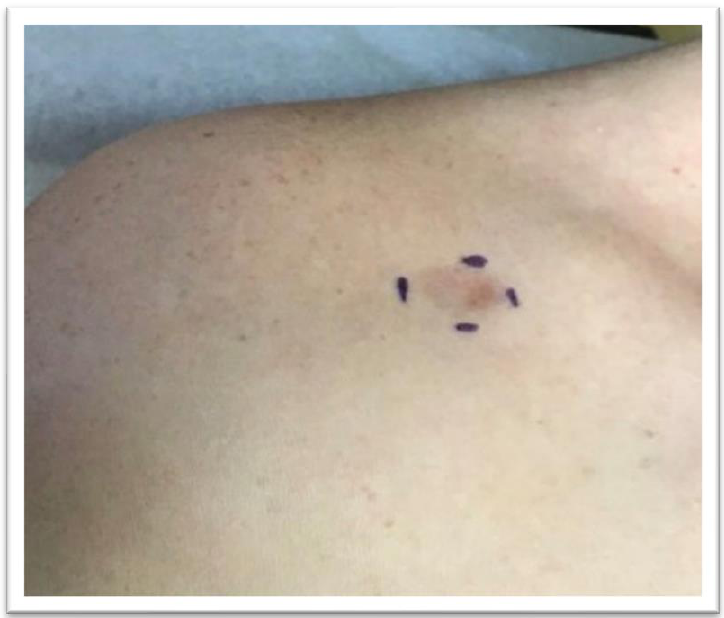
Figure 1. A 2.5 cm erythematous to violaceous atrophic patch with a firm papule at the inferior lateral aspect.